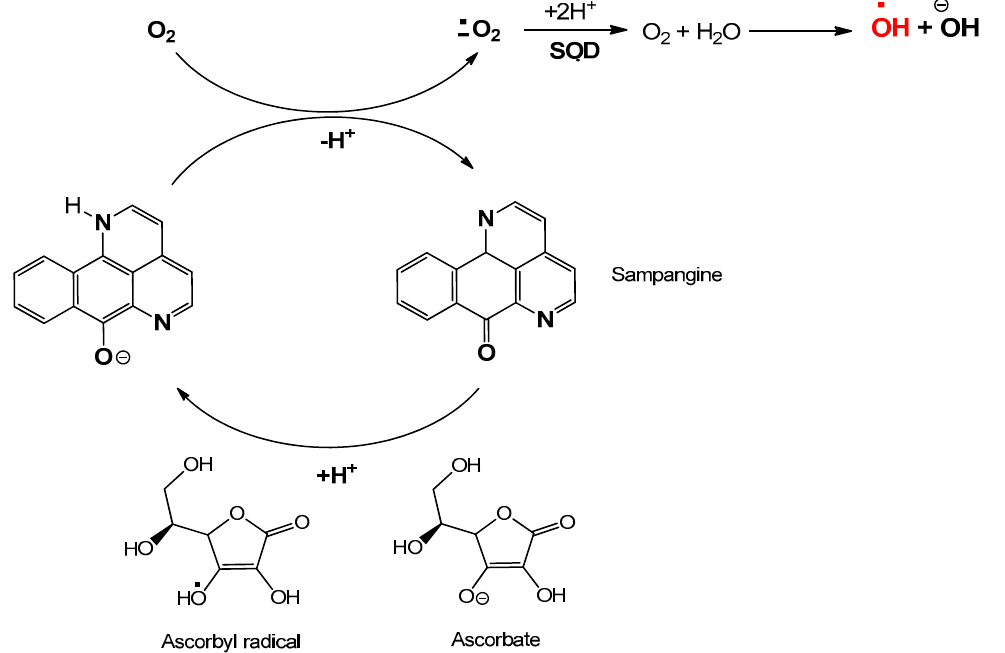
Figure 8. Once cycle in ascorbate-coupled redox cycling of sampangine to produce reactive oxygen species (ROS) [99].